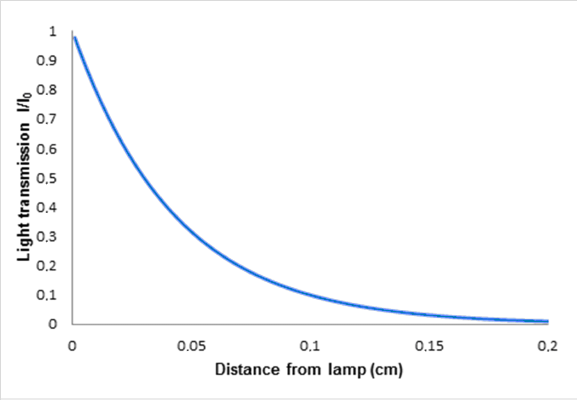
Figure 2: Transmission profile of a 0.05 M solution, ε = 200 M − 1 cm − 1